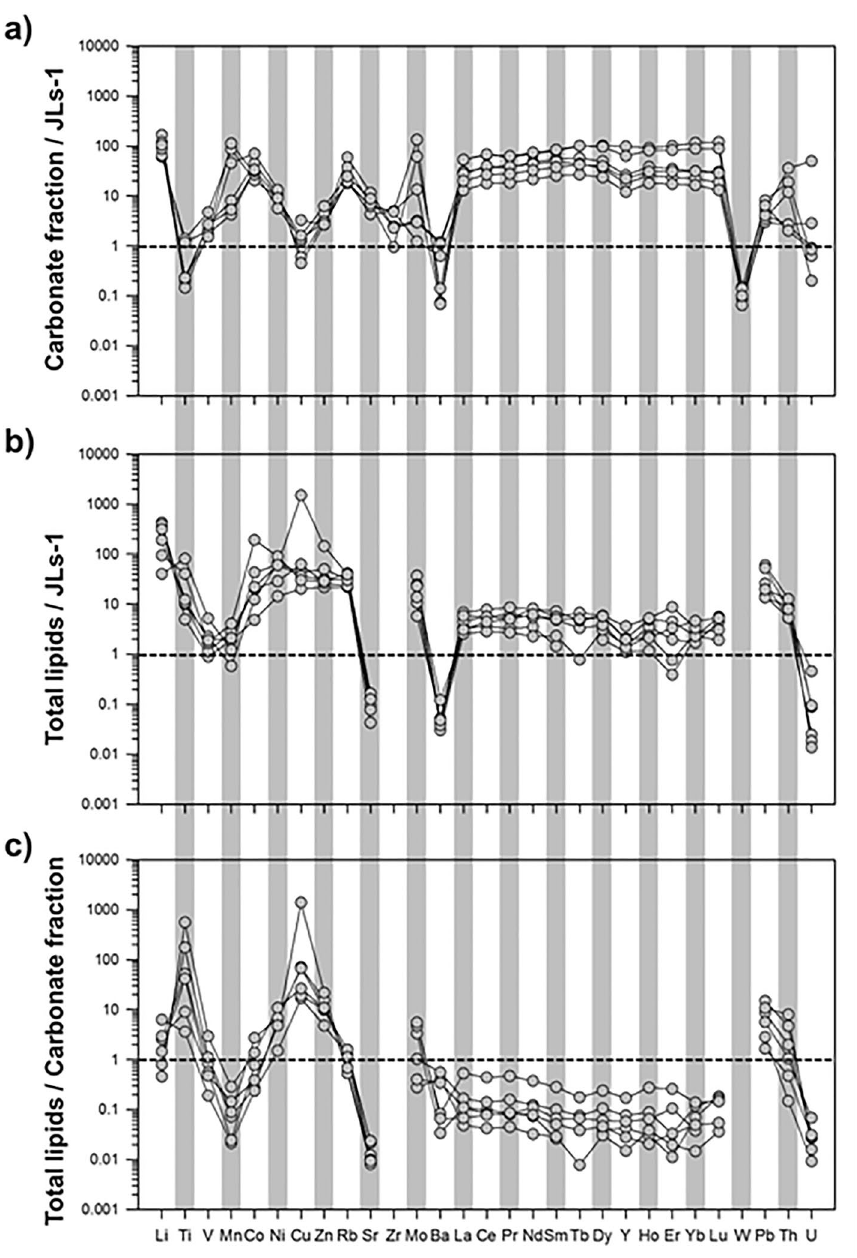
Figure 2. Enrichment factors of ( a ) carbonate fraction (1 M AA leachates) data normalized to values for the JLs-1 carbonate reference material, ( b ) total lipid fraction data normalized to values for the JLs-1 carbonate reference material, and ( c ) total lipid fraction data normalized to values for the corresponding carbonate fractions (1 M AA